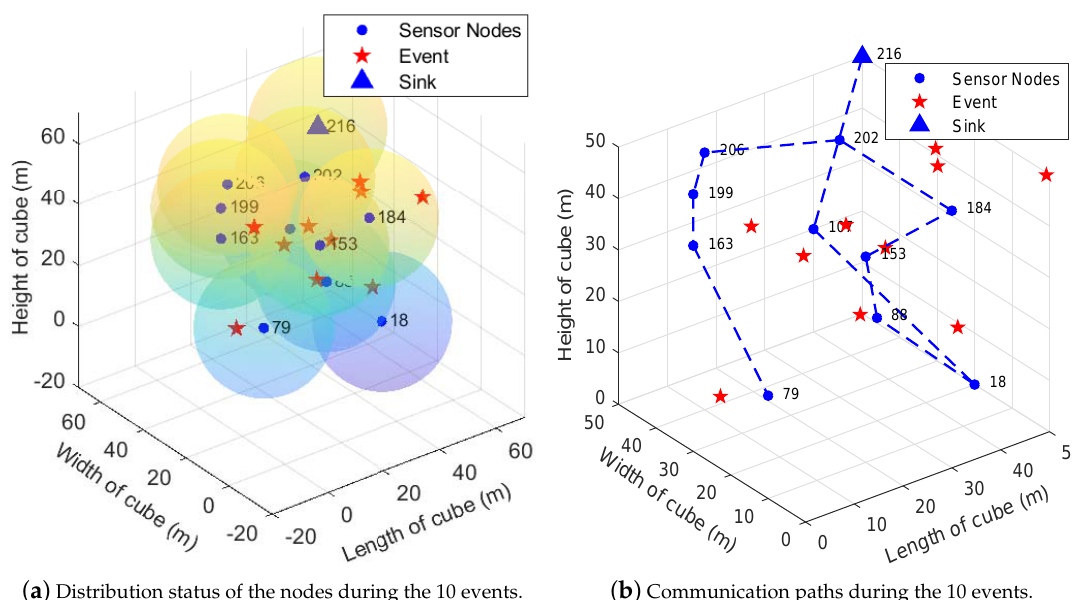
Figure 4. Experiment 1: 10 events that were randomly distributed (unit: m).